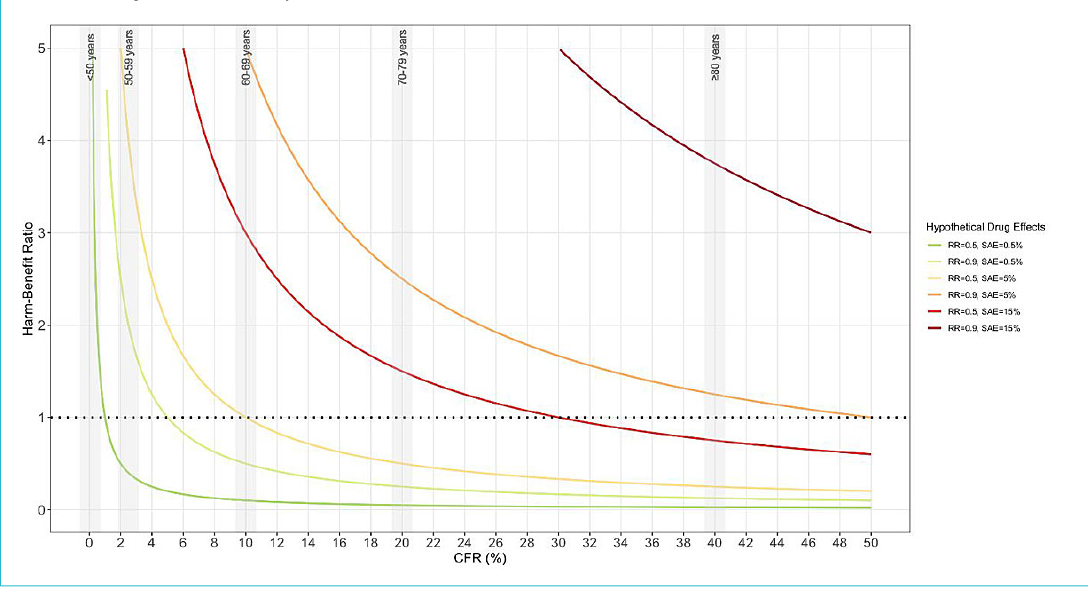
Figure 1: Harm-benefit ratios for off-label drugs with different efficacy and safety profiles across case fatality ratios. Note: The depicted harm- benefit ratios for off-label drugs indicate the ratio between harms (i.e. serious adverse events and death due to an off-label treatment) and benefits (i.e. reduced infection-related mortality due to an off-label treatment). An off-label drug with a harm-benefit ratio <1.0 indicates a net beneficial effect for the given patient population with a specific baseline case fatality ratio. A rate ratio of <1.0 indicates a protective effect